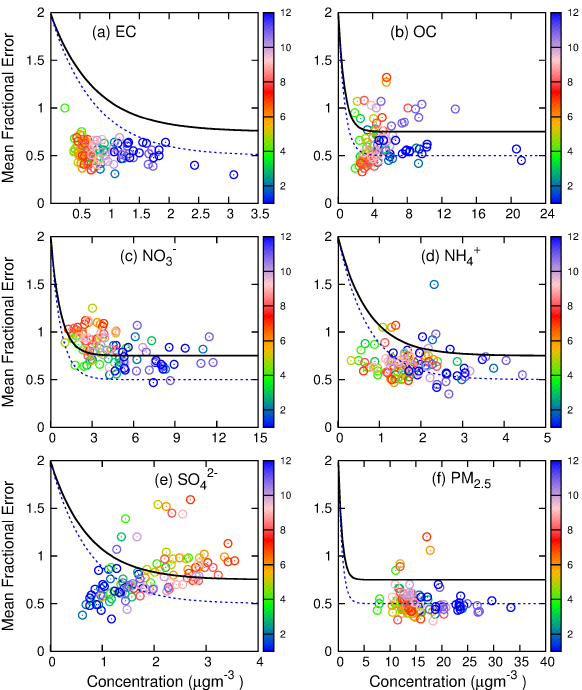
Figure 3. Monthly mean fractional errors (MFE) of PM 2 . 5 EC, OC, nitrate, ammonium, sulfate, and total mass. Solid lines represent the MFE criteria, and the blue dash lines represent the MFE